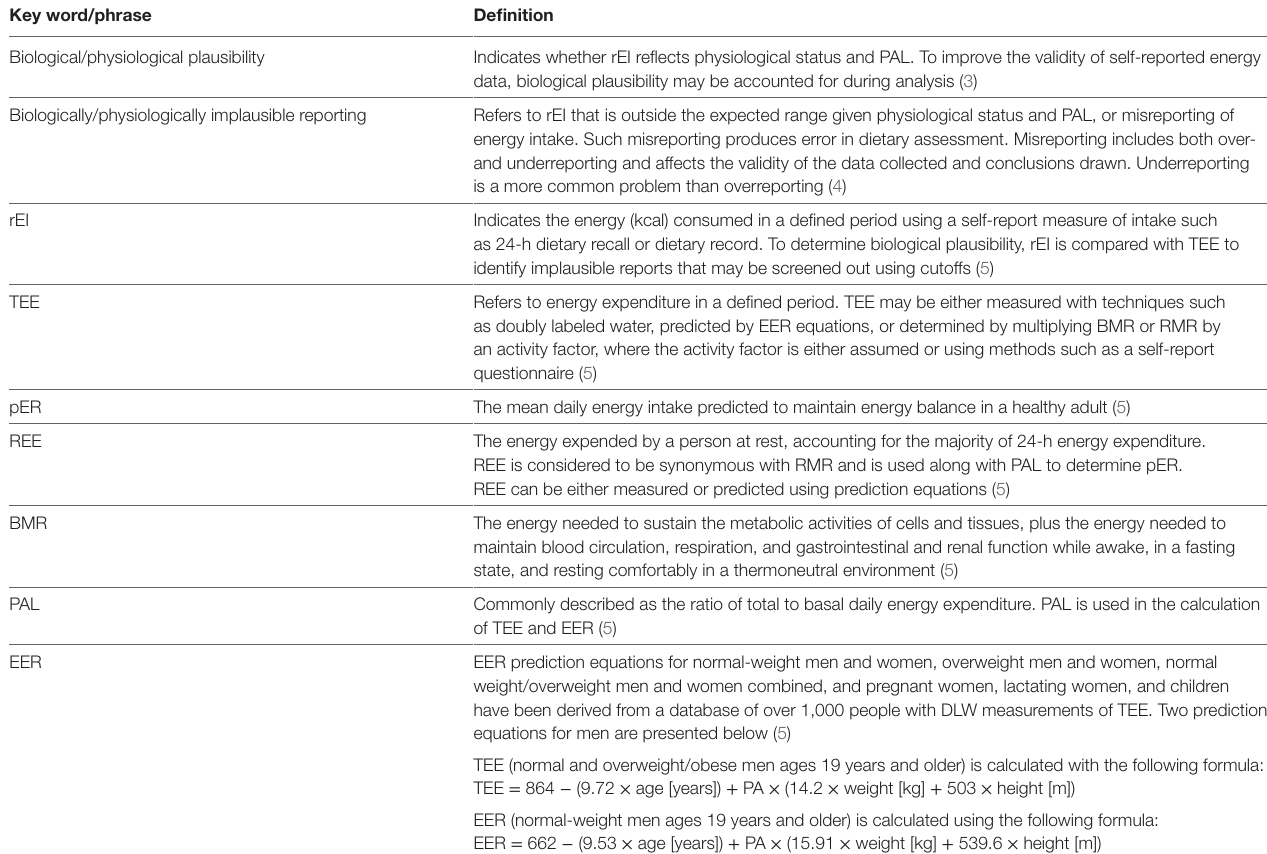
table 1 | Definition of key words related to topic of plausibility of self-report energy intake data. Key word/phrase Definition Biological/physiological